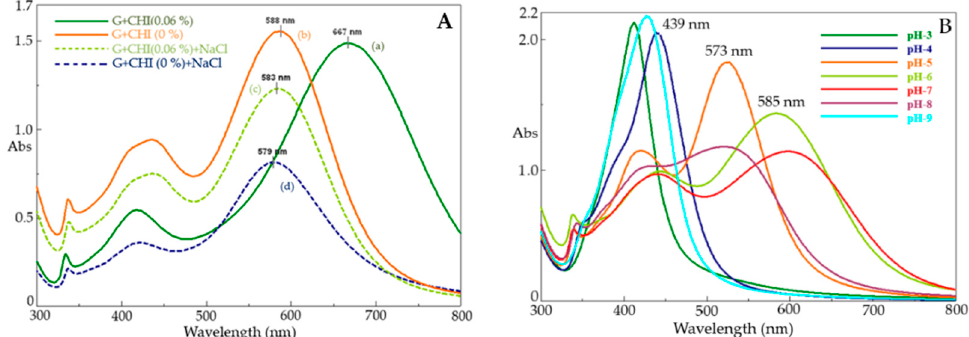
Figure 5. ( A ) UV-Vis spectra of triangular AgNPs colloidal dispersions synthesized with chitosan 0.06% ( w / v ) (gelatin 0.2%, w / v ) (curve a), without chitosan (gelatin 0.2%, w / v ) (curve b), with the presence of chitosan 0.06% after adding NaCl 1.0 M (curve c), and without chitosan after adding NaCl 1.0 M (curve d). ( B ) UV-Vis spectra of triangular AgNPs synthesized at di ff erent pH values (from 3.0 to 9.0)